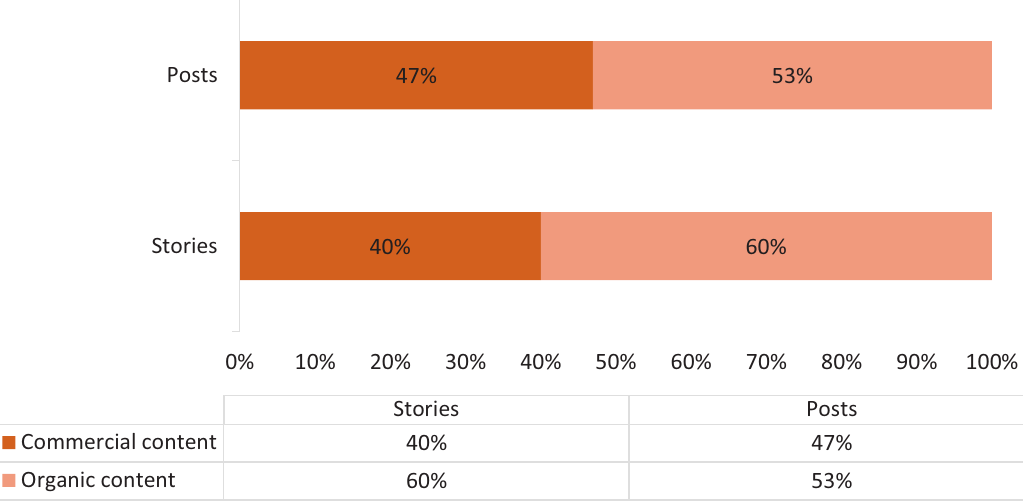
Figure 1. Commercial and organic content.